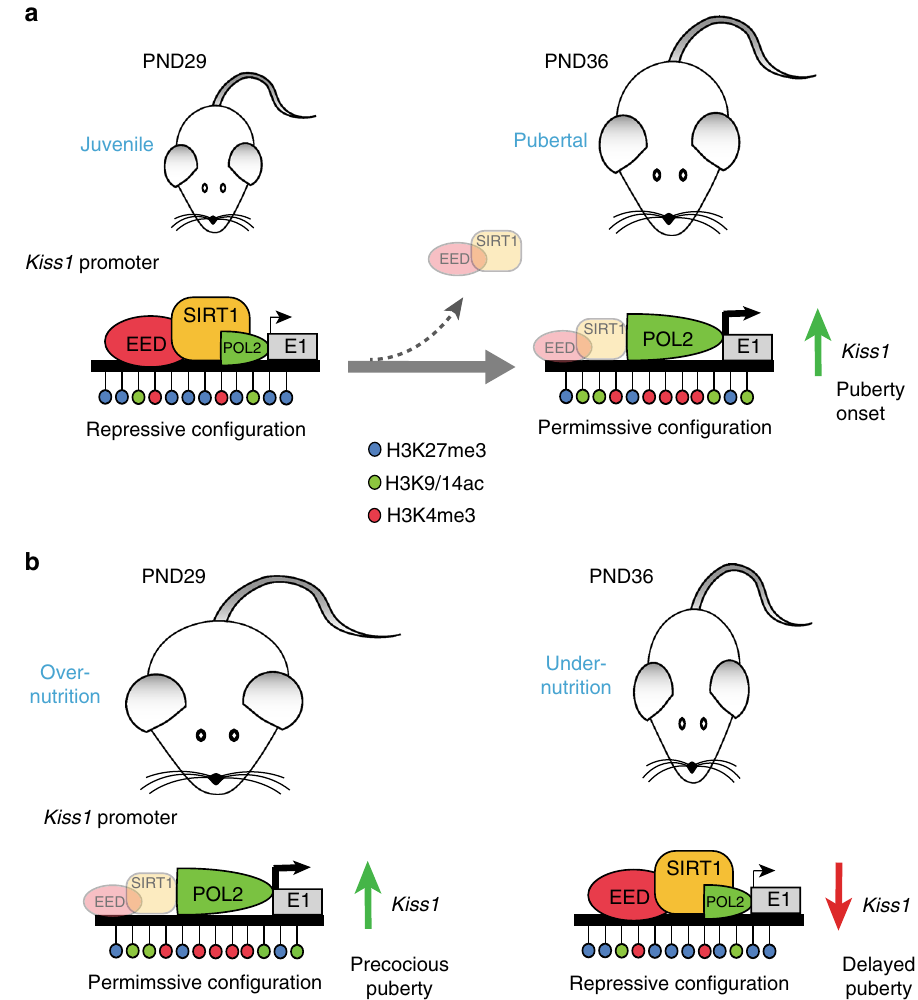
Fig. 9 Mode of SIRT1 action in the control of puberty and its modulation by metabolic cues. a Major events occurring during normal female pubertal maturation. Transition from late juvenile (PND29; left panel) to peripubertal (PND36; right panel) stages is de fi ned by eviction of SIRT1 and EED, a key member of the PcG silencing complex, from the Kiss1 promoter in KNDy neurons, which changes the chromatin landscape from a predominantly repressive to a permissive histone con fi guration. According to this model, these changes would result in enhanced Kiss1 transcription, mandatory for puberty onset.